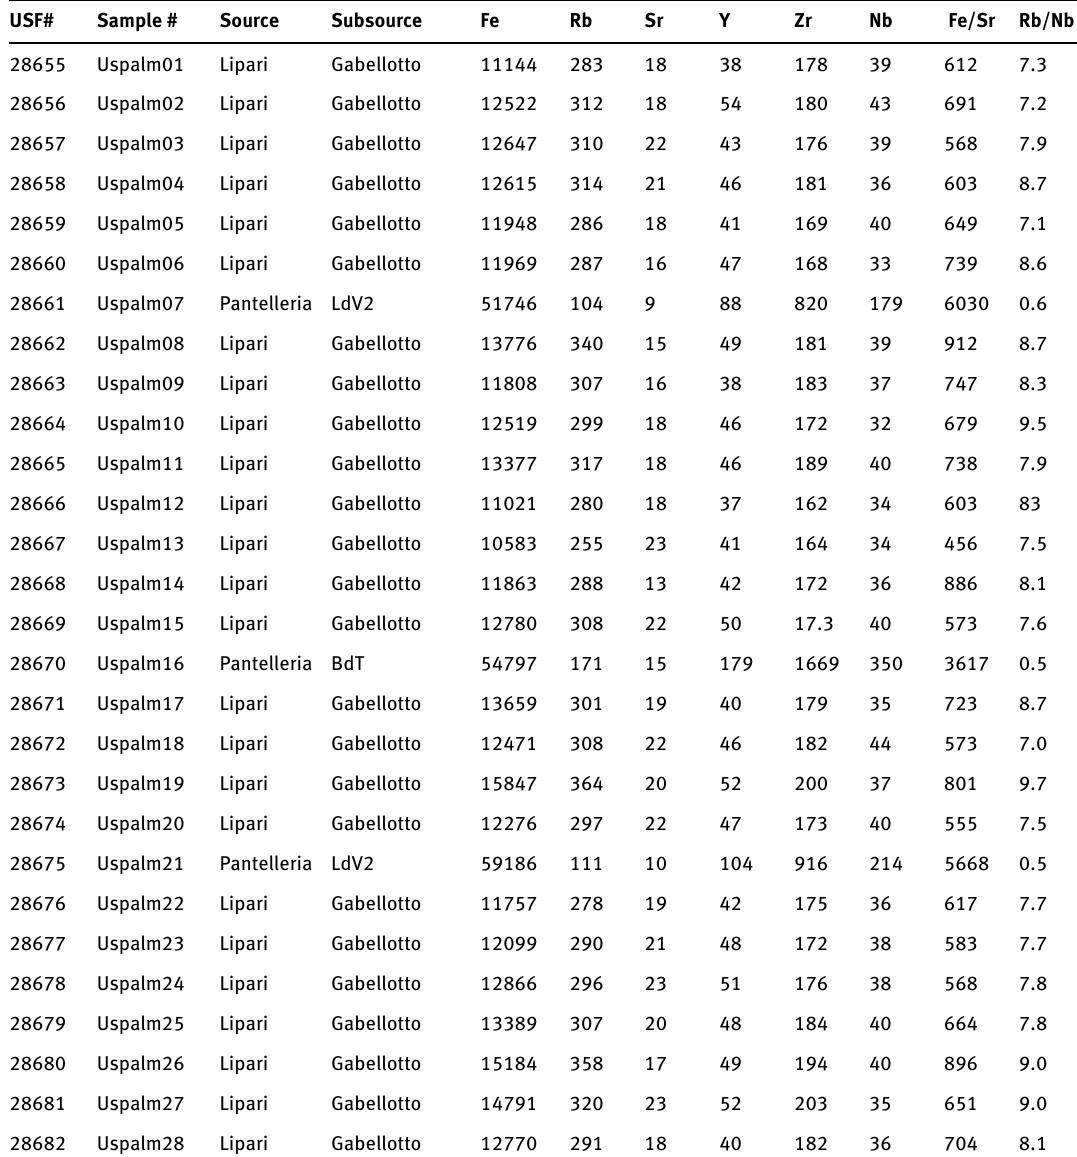
Table 2. pXRF analyses (data in